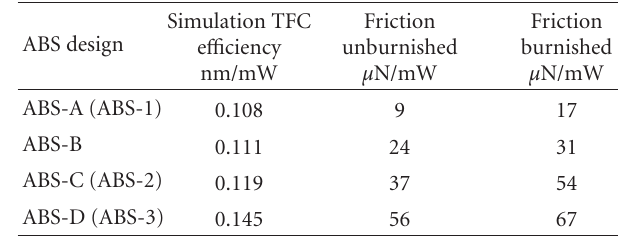
Table 3: E ff ect of TFC e ffi ciency (ABS/heater design) on